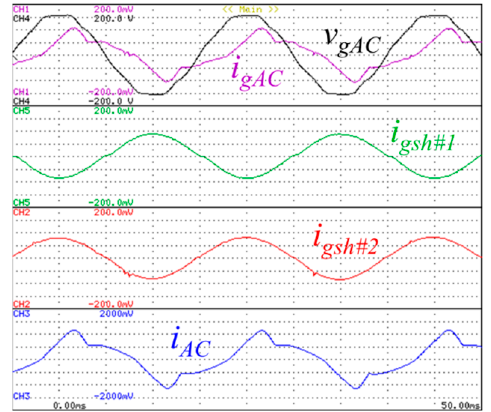
Figure 11. Experimental results showing the voltage ( v gAC ) (100 V/div) and the current ( i gAC ) (5 A/div) on the main AC grid, the current consumed by each front-end AC/DC converter of each smart home ( i gsh# 1 and i gsh# 2 ) (5 A/div), and the current of the AC grid of smart home #1 ( i ACsh# 1 ) (5 A/div).